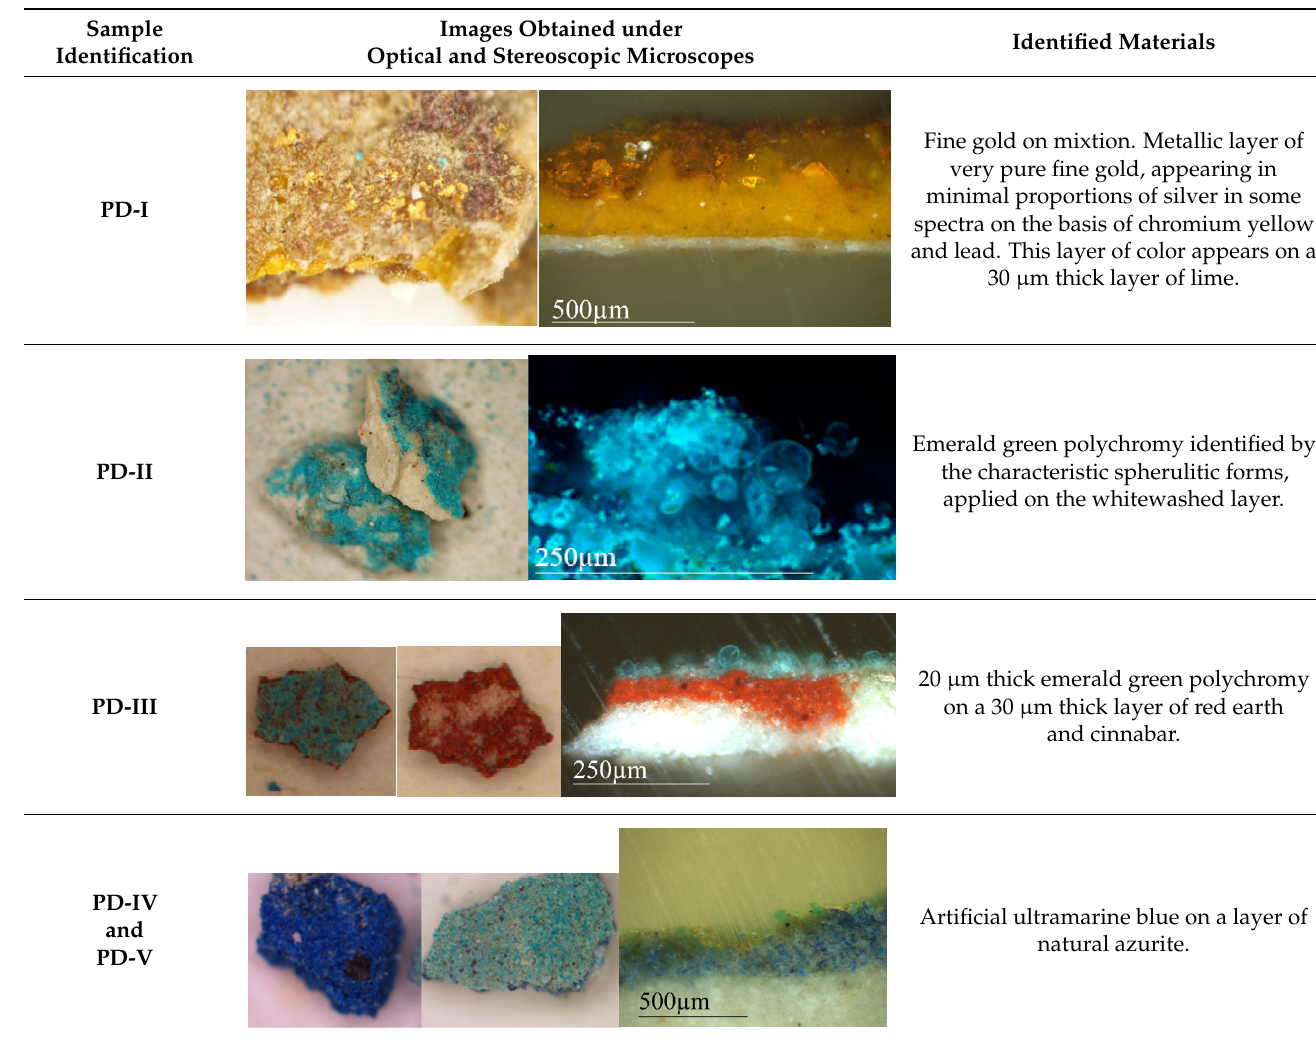
Table 1. Summary of the results obtained through microscopy analysis.